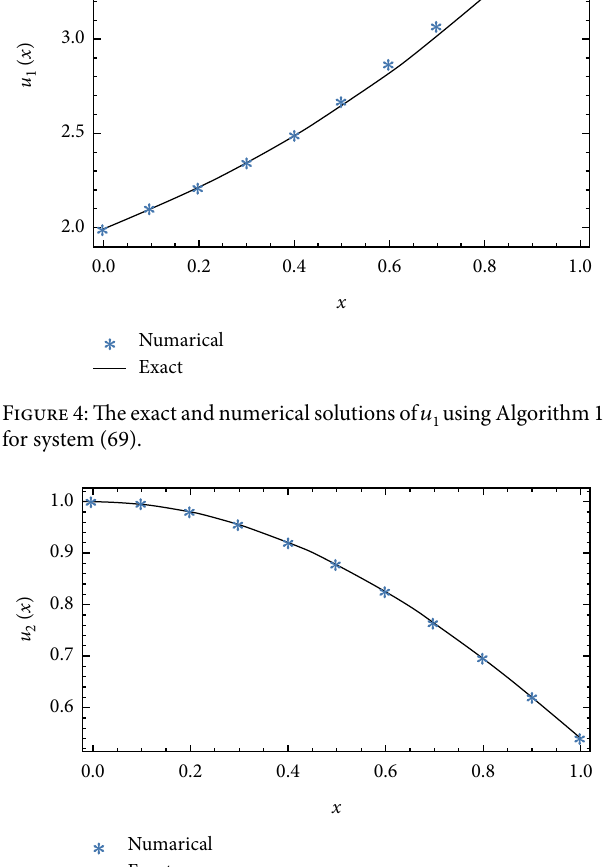
using Algorithm 1 𝑢 2